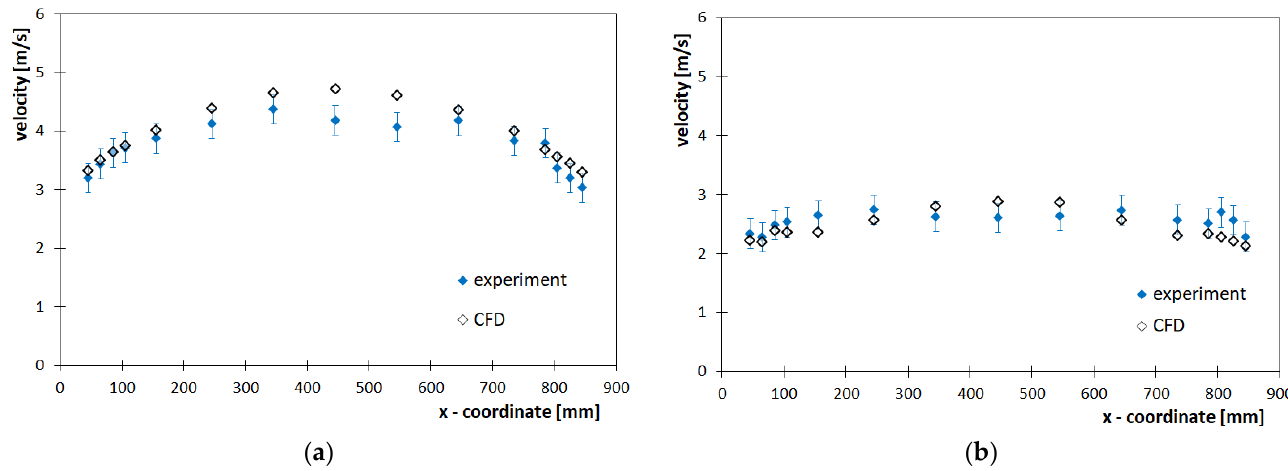
Figure 6. Velocity profile behind the plate: ( a ) for measurement row No.3 (y = 218 mm); ( b ) for row No.6 (y = 518 mm).